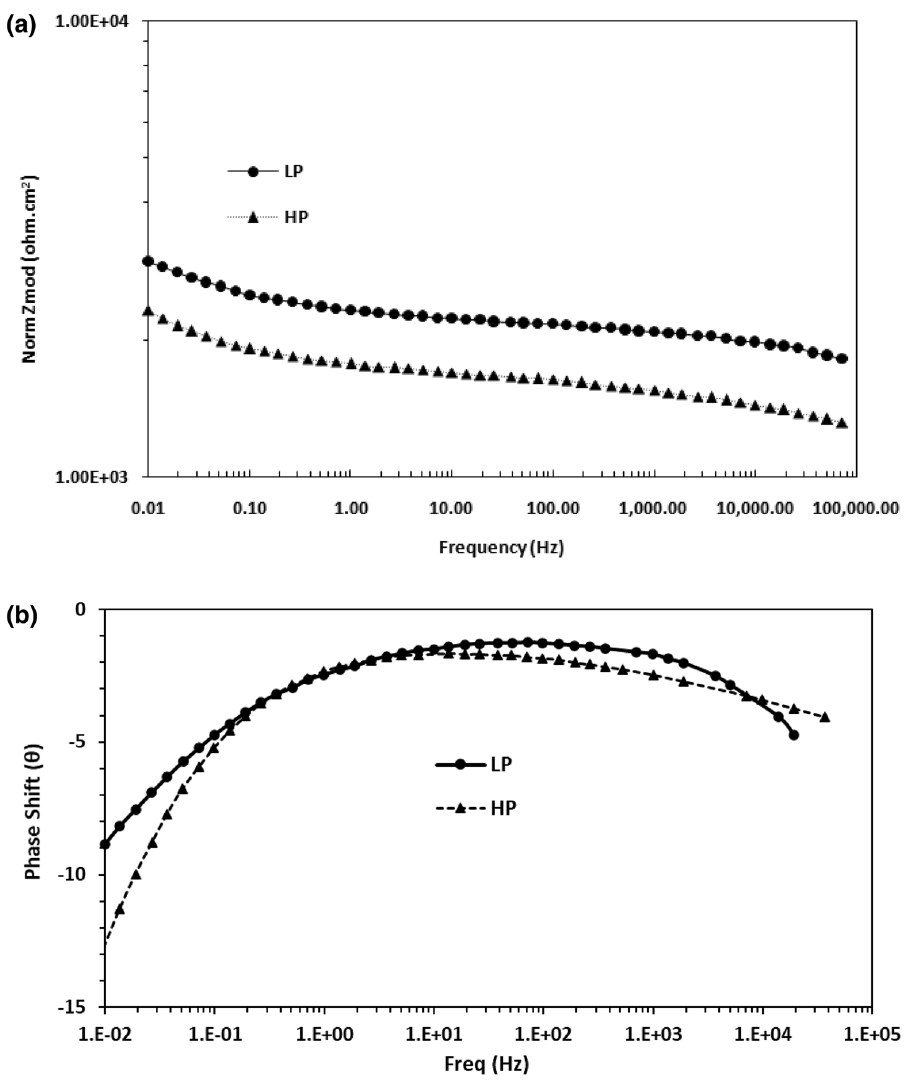
Figure 21. ( a ) Bode log frequency–log impedance plots for LP and HP steel rebars embedded in mortars after 10th cycle of wet/dry treatment in chloride solution. ( b ) Bode log frequency–phase shift plots for LP and HP steel rebars embedded in mortars after 10th cycle of wet/dry treatment in chloride solution.